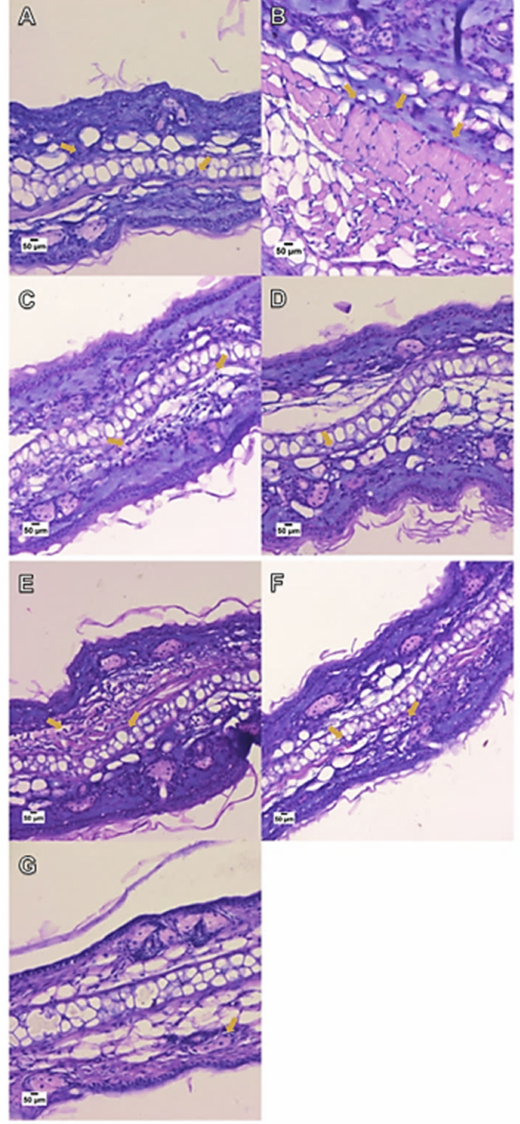
Figure 11. Effect of the hydrogels containing free or nanoencapsulated sesamol topically applied (15 mg/ear) on the polymorphonuclear cell infiltration in the croton-oil-induced ear edema model in Swiss mice. The image presents the histological changes ( A – G ; hematoxylin–eosin 20 × objectives) of the ear tissue of mice at 6 h after the croton oil application or croton oil plus treatments. ( A ) naive; ( B ) croton oil (1 mg/ear) (no treatment); ( C ) croton oil (1 mg/ear) + Hydrogel vehicle; ( D ) croton oil (1 mg/ear) + Hydrogel NC placebo; ( E ) croton oil (1 mg/ear) + Hydrogel free SES; ( F ) croton oil (1 mg/ear) + Hydrogel NC SES; ( G ) croton oil (1 mg/ear) + 0.5% dexamethasone acetate. The arrows indicate the presence of inflammatory cells in the ear tissue. Scale bar = 50 µ